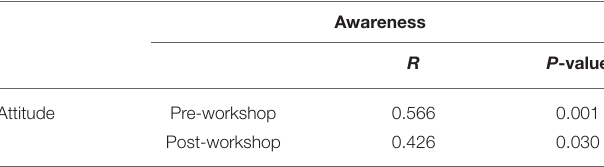
TABLE 3 | Correlation between awareness and attitude score pre- and